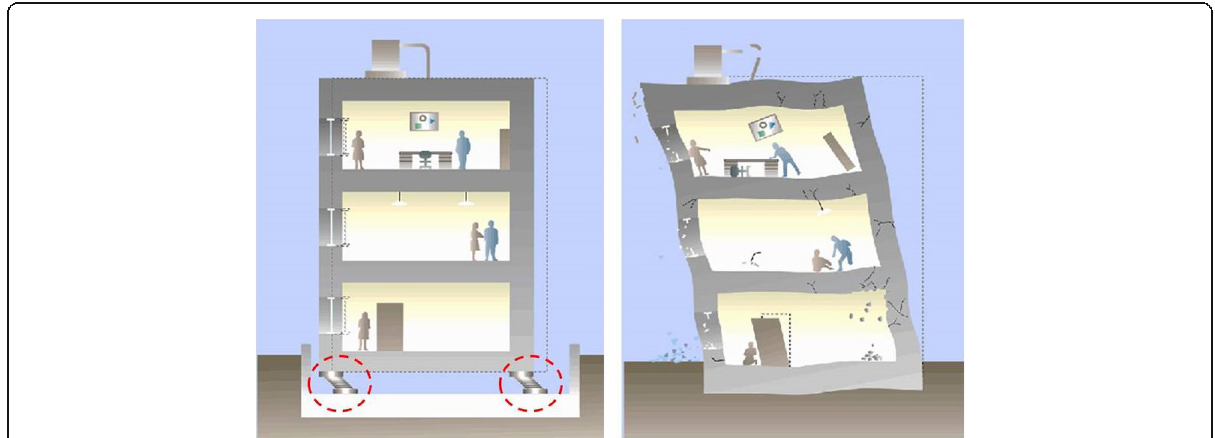
Fig. 4 Seismic isolated structure vs. conventional earthquake-resistant structure